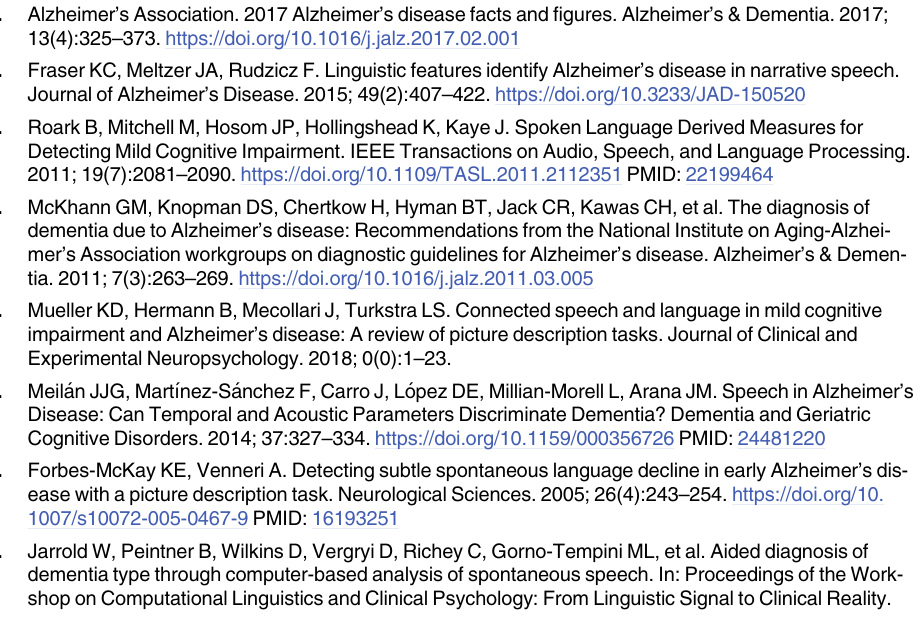
S1 Fig. Demographics survey used on the talk2me